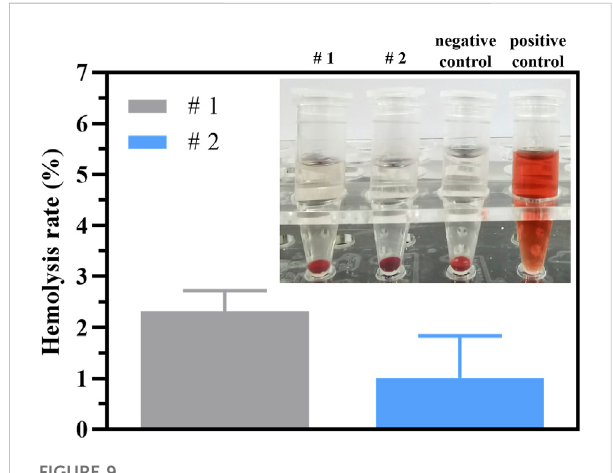
FIGURE 9 Hemolysis rate of pTi (#1) and Ti-Cu@P(DA-co-SBMA) (#2) and images of hemolysis test of negative control, positive control, pTi (#1) and Ti-Cu@P(DA-co-SBMA)